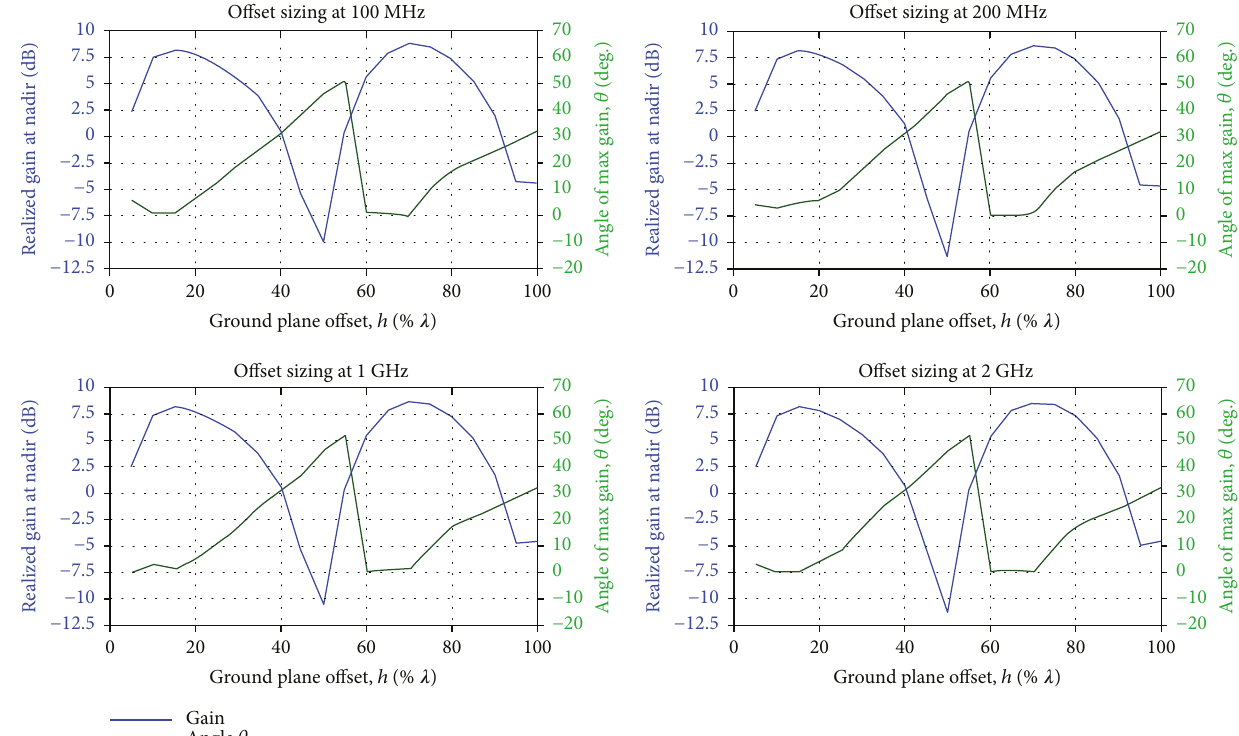
Figure 16: Ground plane o ff set versus realized gain at nadir and angle of max gain plot for all operating frequencies.